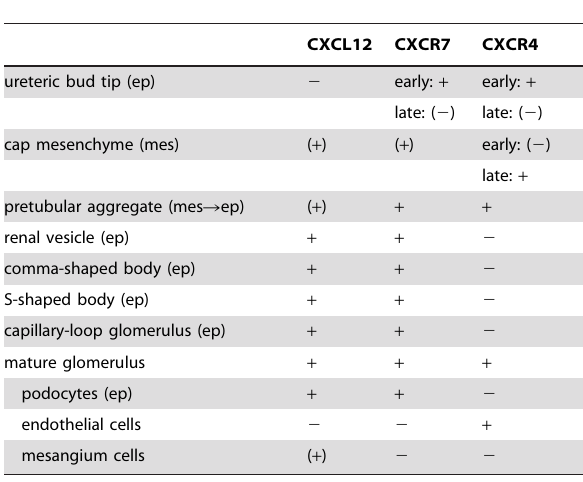
Table 1. Expression of CXCL12, CXCR7 and CXCR7 mRNA during